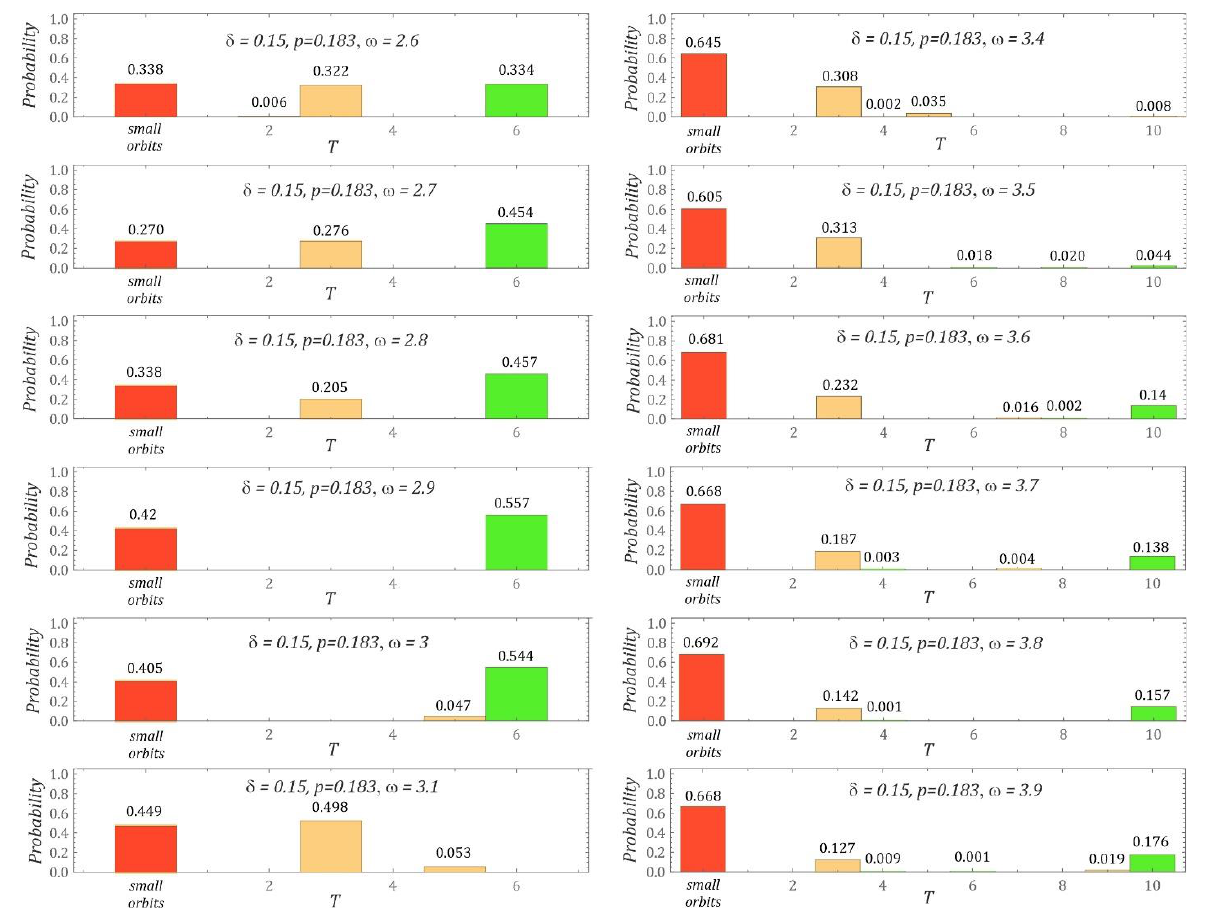
Figure 8. Numerical results showing the influence of potential asymmetry on the probability of occurrence (periodicity diagrams) of individual solutions for different values of ω ( ω = 2.6, 2.7, 2.8, 2.9, 3.0, 3.1, 3.4, 3.5, 3.6, 3.7, 3.8, and 3.9, respectively). The colors represent the different orbits of δ parameter.